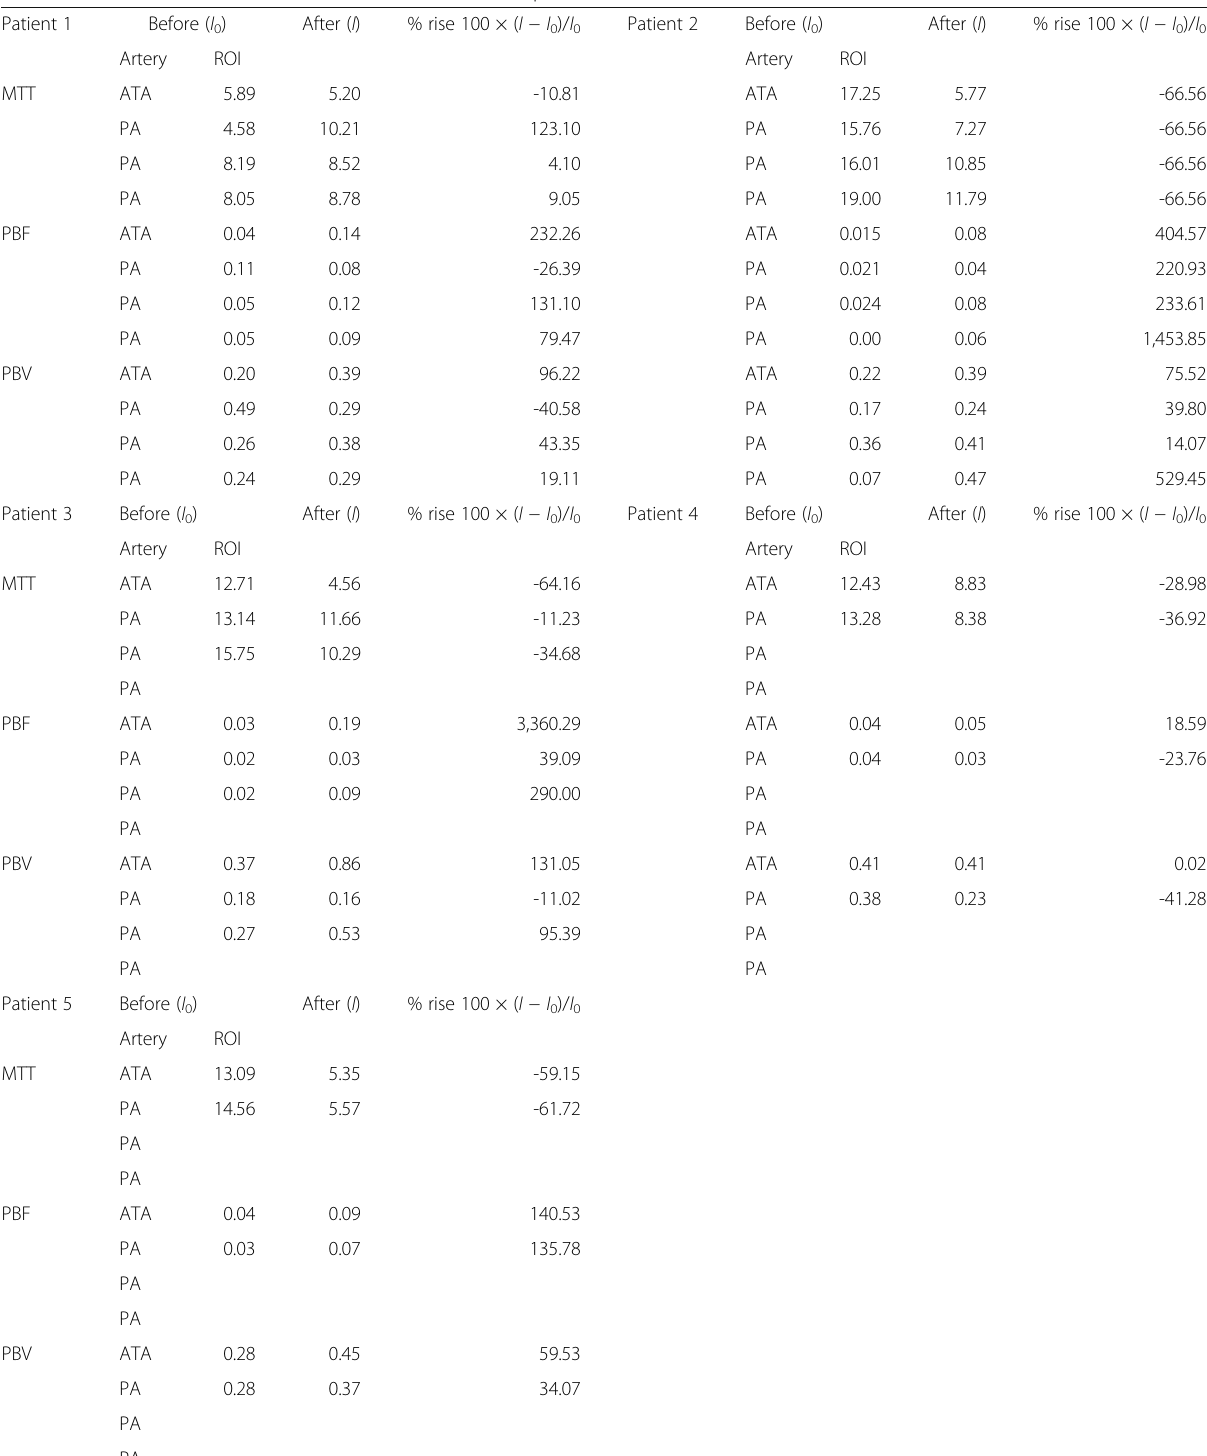
Table 2 Preoperative (Io) and postoperative (I) values of MTT, PBF, and PBV along with the postoperative percent rise on the user- defined ROIs set on ATA and PA areas for each of the five patients Patient